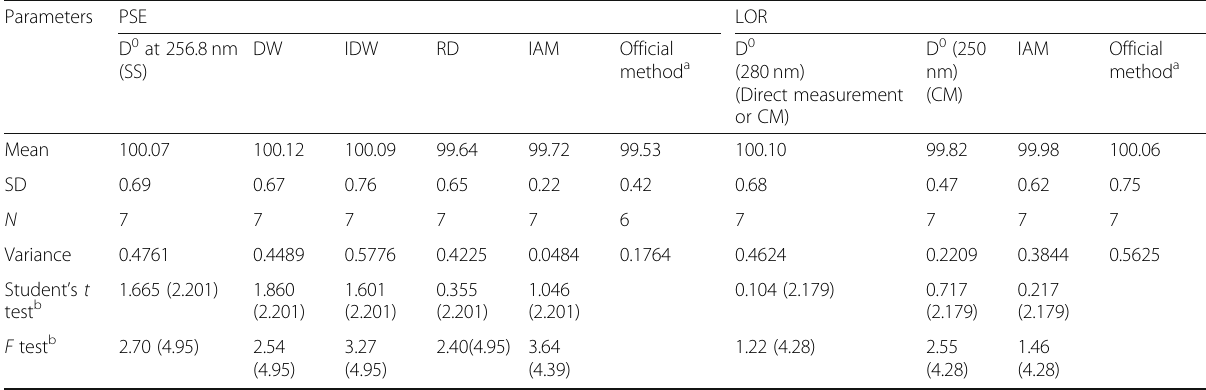
Table 4 Statistical comparison of the results obtained by the proposed spectrophotometric methods and those obtained by the official ones for the determination of PSE and LOR in their pure powdered forms Parameters